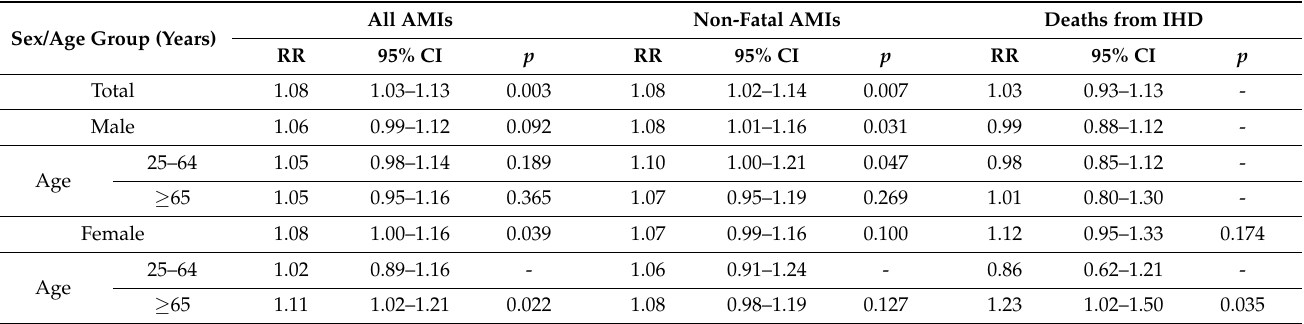
Table 5. The effect of geomagnetic storm (the periods of 3 days before GS, days of GS, and 1 day after GS) on the risk of AMI and death from IHD during spring–autumn by sex and age group.